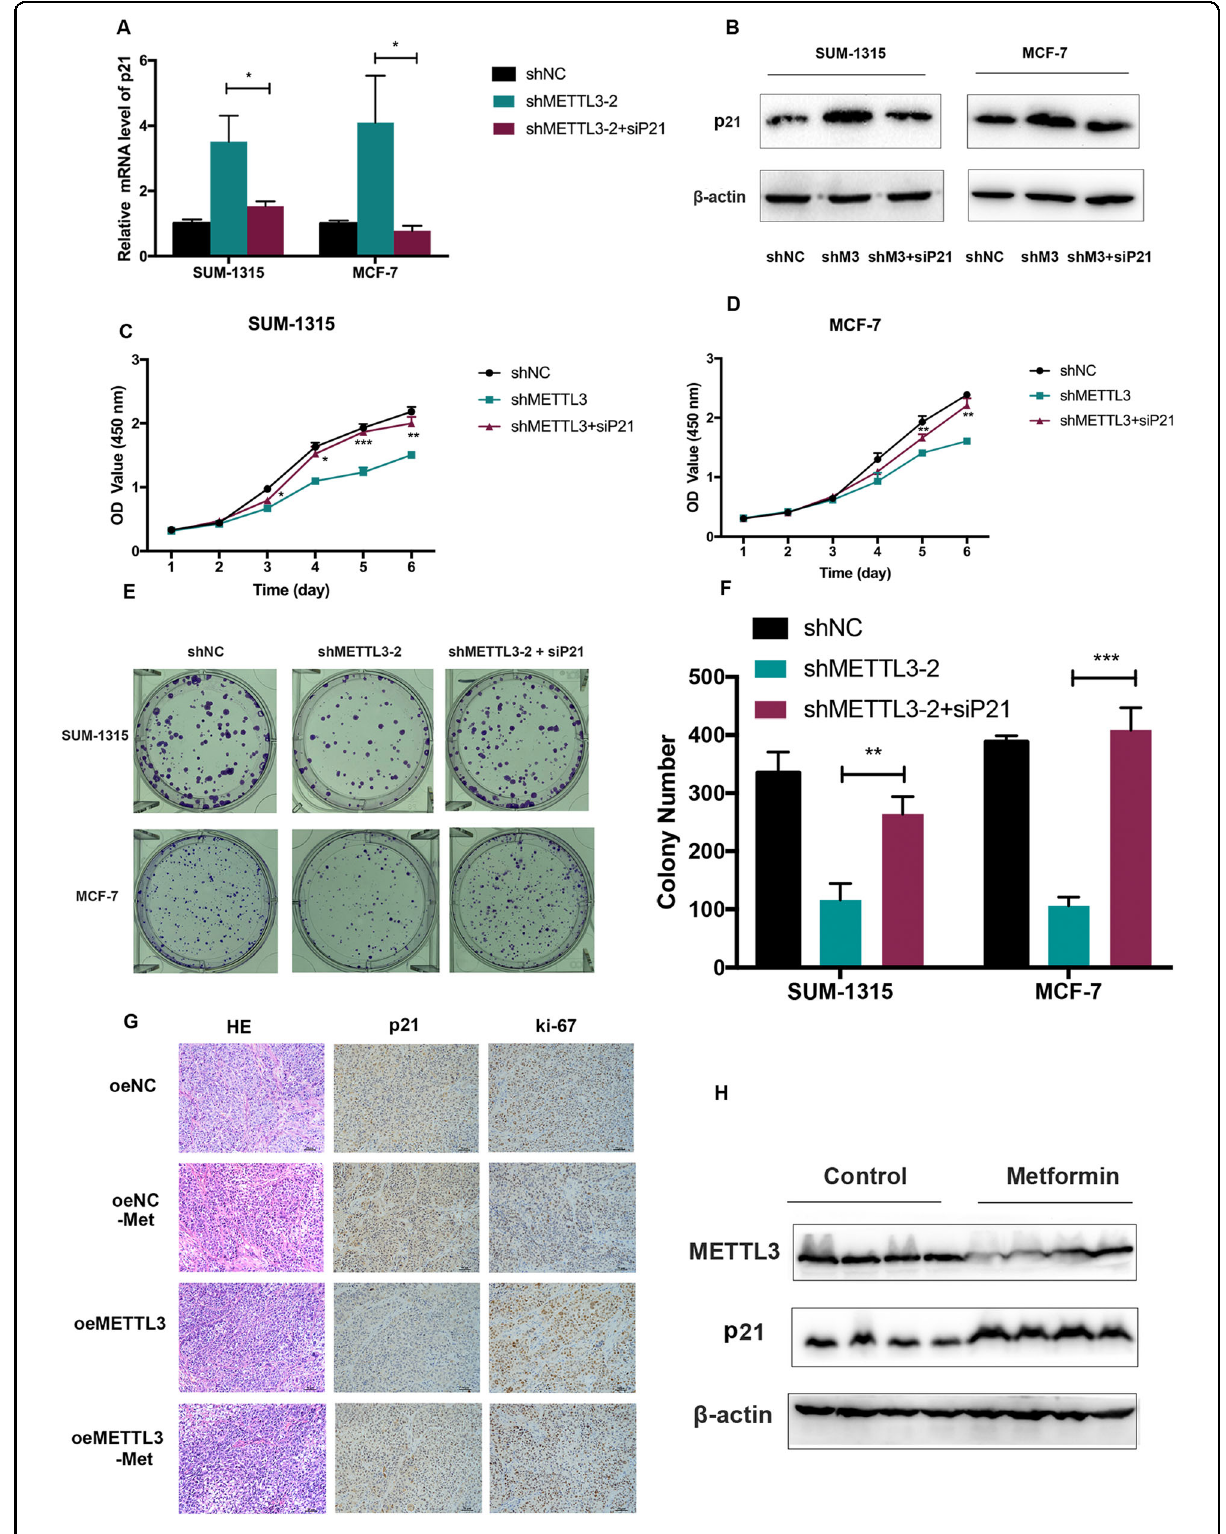
Fig. 5 (See legend on next